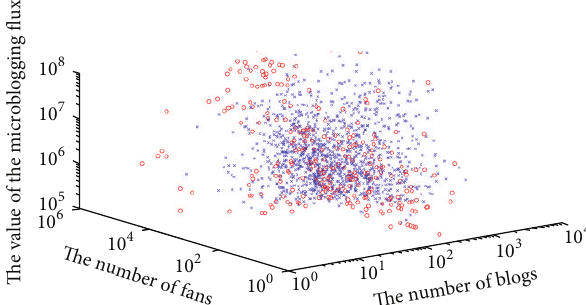
Figure 8: The microbloggers whose 𝑀 1500; the red nodes represent the VIP users.